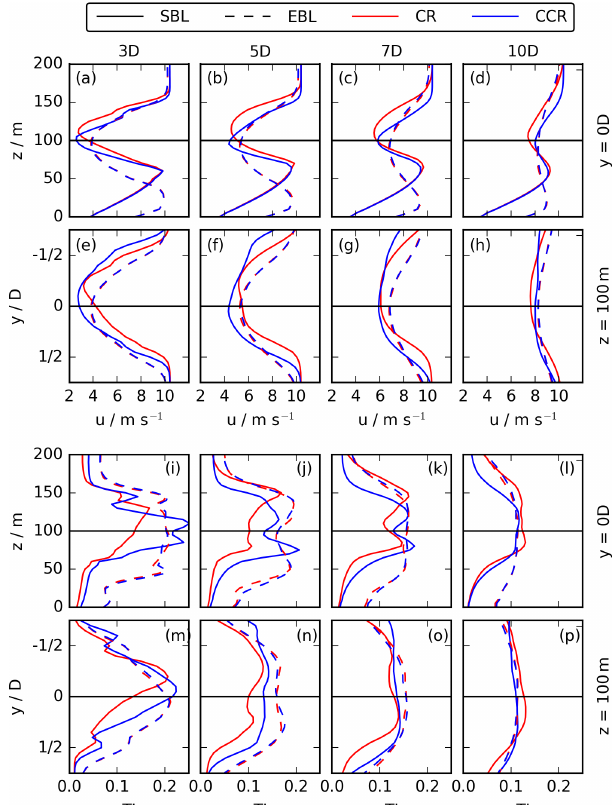
Figure 11. Vertical and spanwise profiles of u (first two rows) and TI (last two rows) through the centre of the rotor at y =0D and z = 100m for the SBL and the EBL wind-turbine simulations at x = 3D (first column), 5D (second column), 7D (third column), and 10D (fourth column) downwind and for both rotational directions CR and